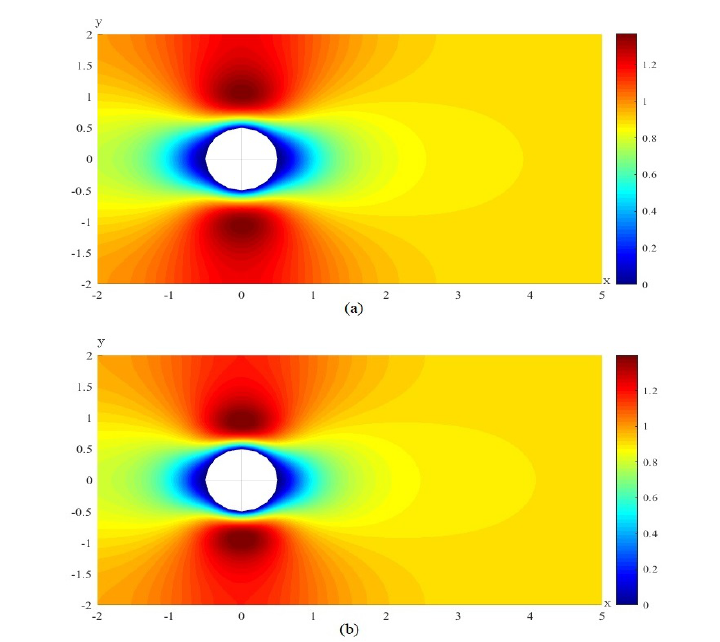
Figure 2. ( a ) The CNMFE solution u n